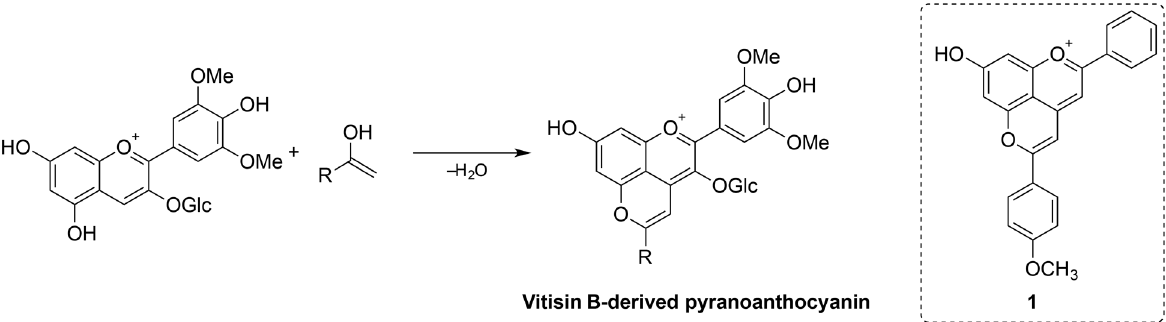
Figure 4 - Formation of a Vitisin B type pyranoanthocyanin via a reaction of malvidin (oenin), the predominant anthocyanin in Vitis vinifera grapes, with the enol form of a copigment during the maturation of red wine (Oliveira et al. 2014; Vallverdú-Queralt et al. 2016), together with the structure of a typical synthetic pyranoflavylium cation 1 (Chassaing et al. 2015) used to investigate the chemistry and photochemistry of the pyranoanthocyanin chromophore (Freitas et al.